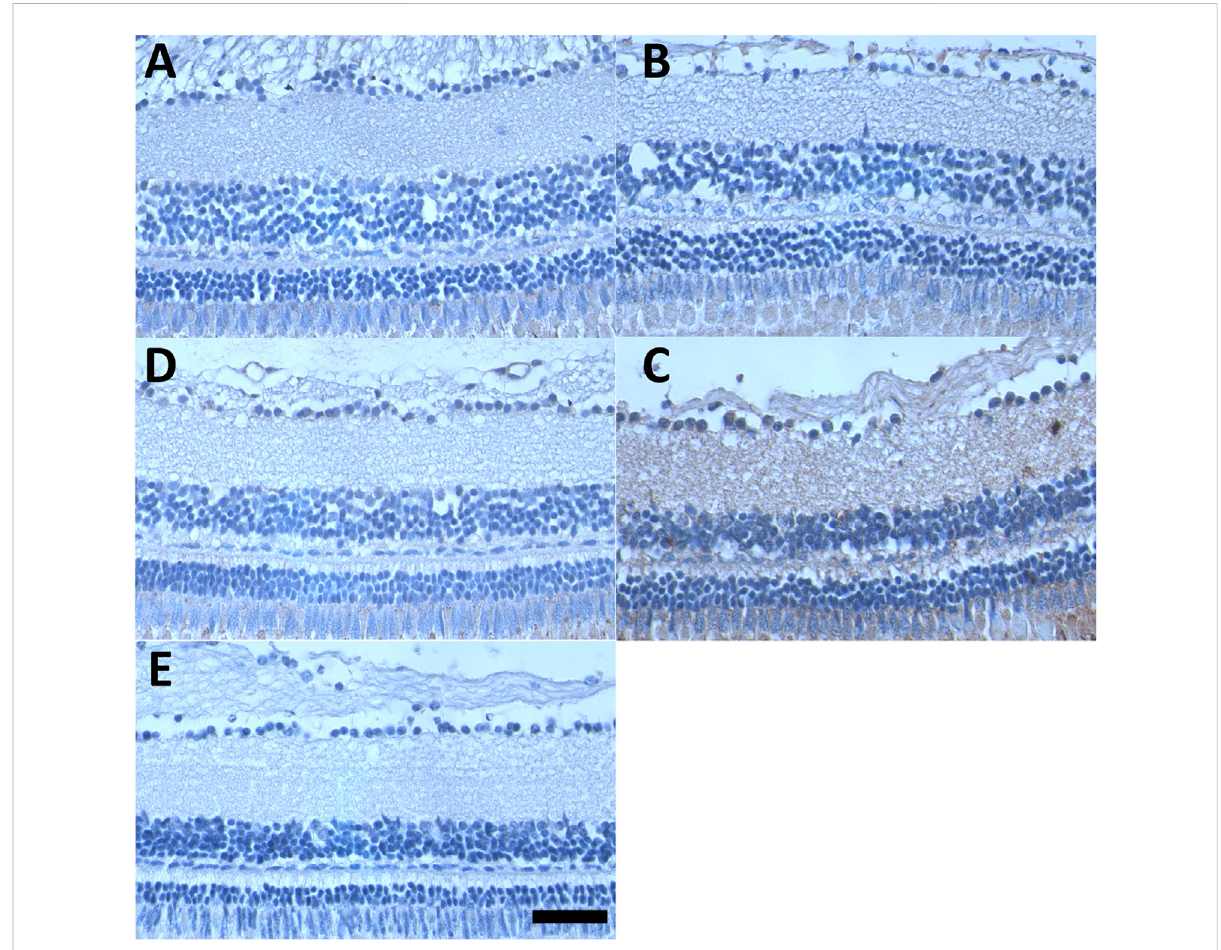
NQO1 prevents CQ-induced oxidative retinal damage. Representative images of nitro-tyrosine staining of the adult zebra fi sh retina. Formalin- fi xed, paraf fi n-embedded sections of adult zebra fi sh retina were subjected to immunohistochemical staining (brown colour) for nitro-tyrosine, (A) DMSO-treated, (B) CQ-treated(10 μ M), (C) Dic-treated(0.5 μ M), (D )CQ+Dic-treated(10 μ M+0.5 μ M) (E) negativecontrol(primaryantibodyin (D) was replaced with non-speci fi c IgG). All the treatments were carried out for 48 h except for the combination treatment (CQ + Dic; (D)